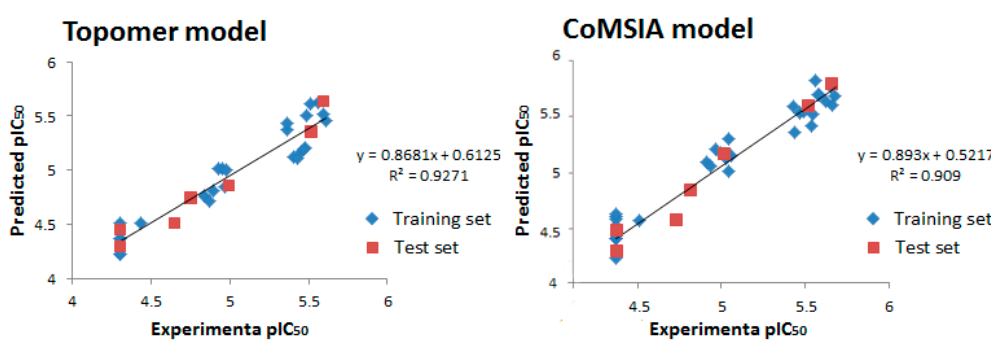
Figure 3. Experimental versus predicted activity of the training and test set based on the Topomer CoMFA model and CoMSIA model.